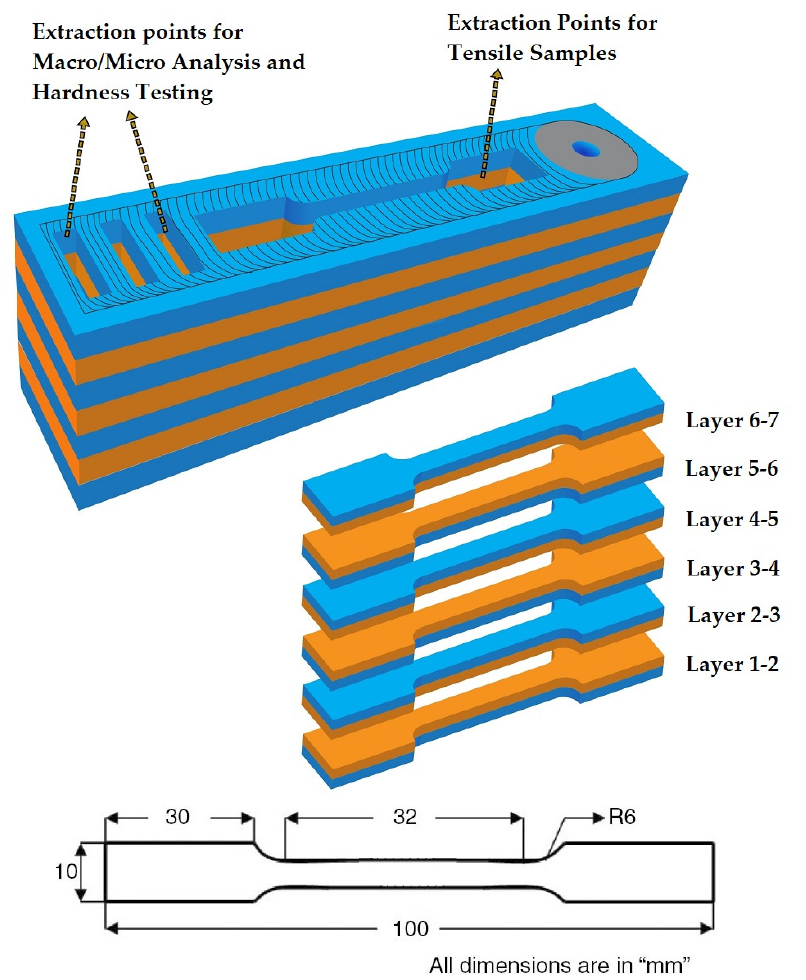
Figure 3. Diagrammatic representation of sample extraction points and tensile sample dimensions.